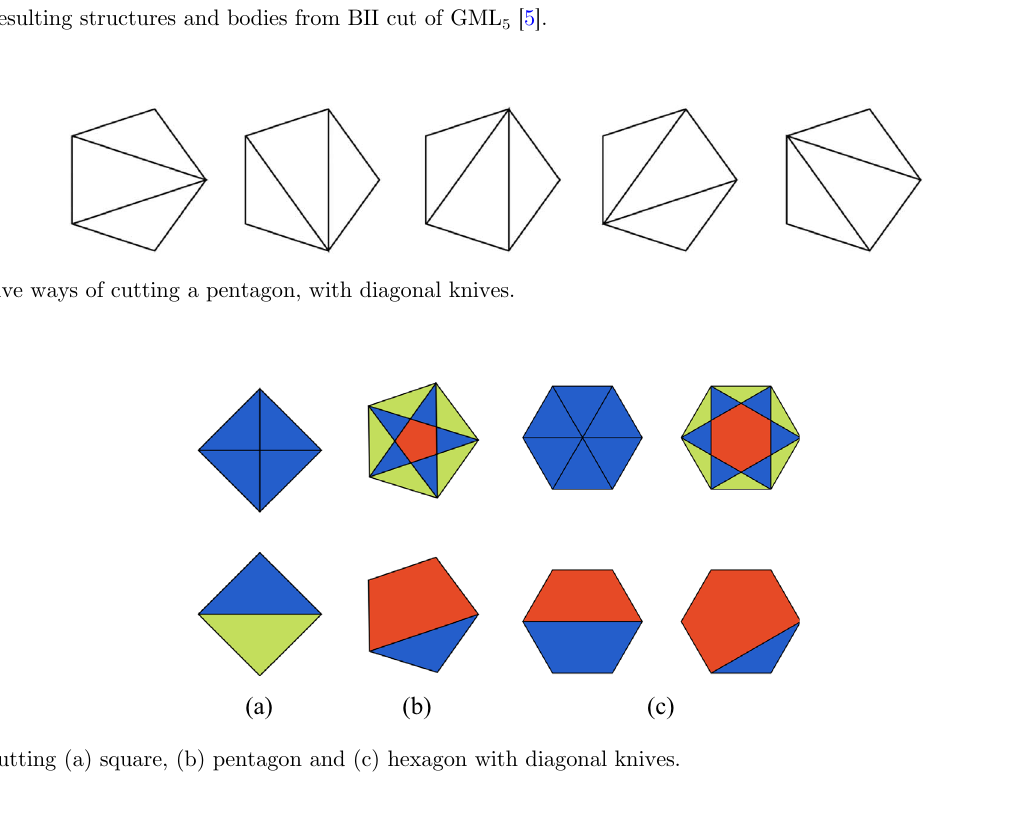
Figure 24. Resulting structures and bodies from BII cut of GML 5 [5].